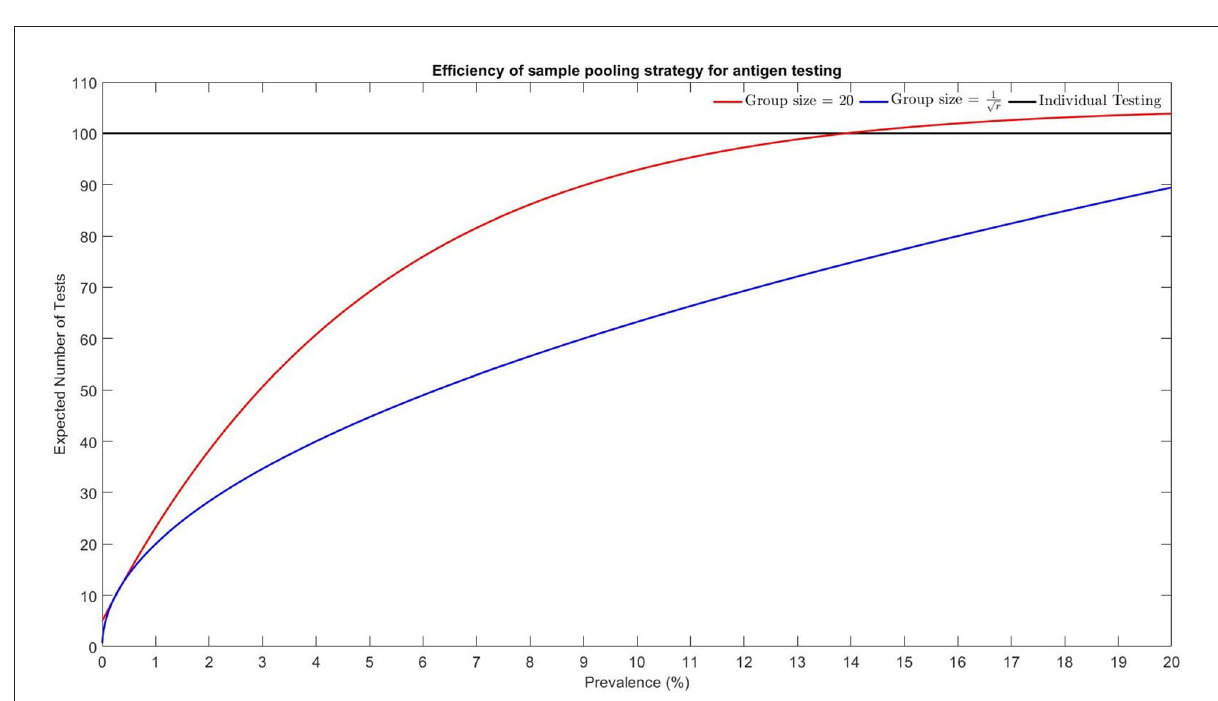
FIGURE4 Efficiency of sample pooling strategy for antigen testing using different batch